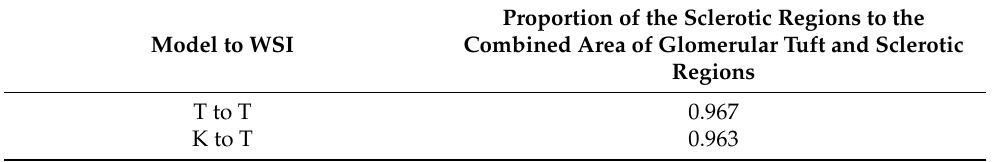
Table A3. Correlation coefficients between the ground truth and predicted regions.